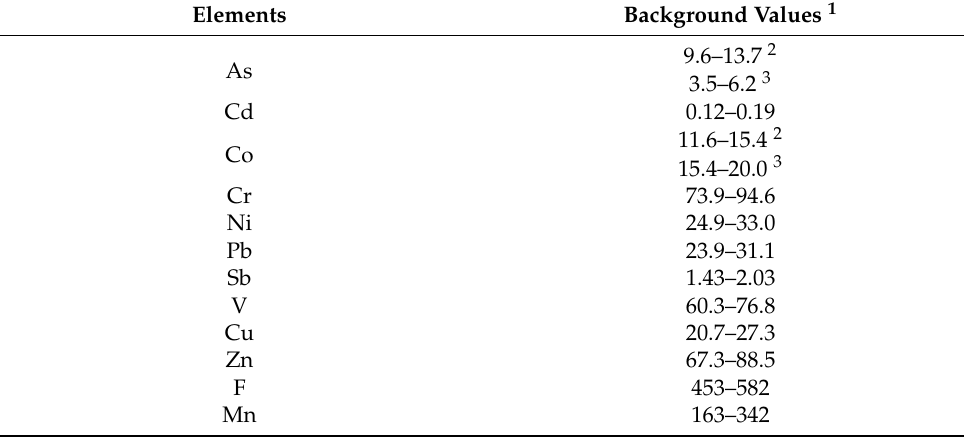
Table A2. Environmental background values of soil heavy metal elements in Wuhu